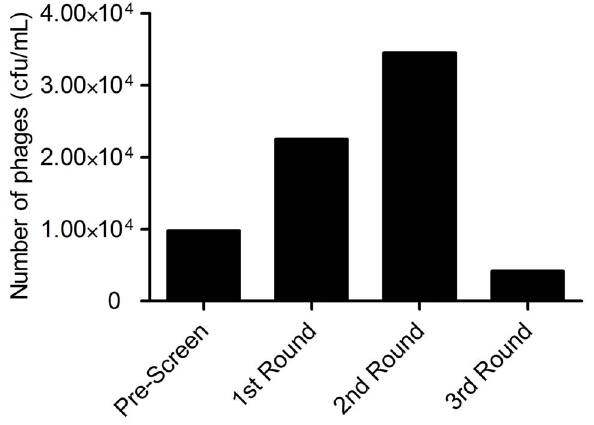
Figure 1. Recoveries from screening phage displayed libraries against the soluble ectodomain of PSMA.